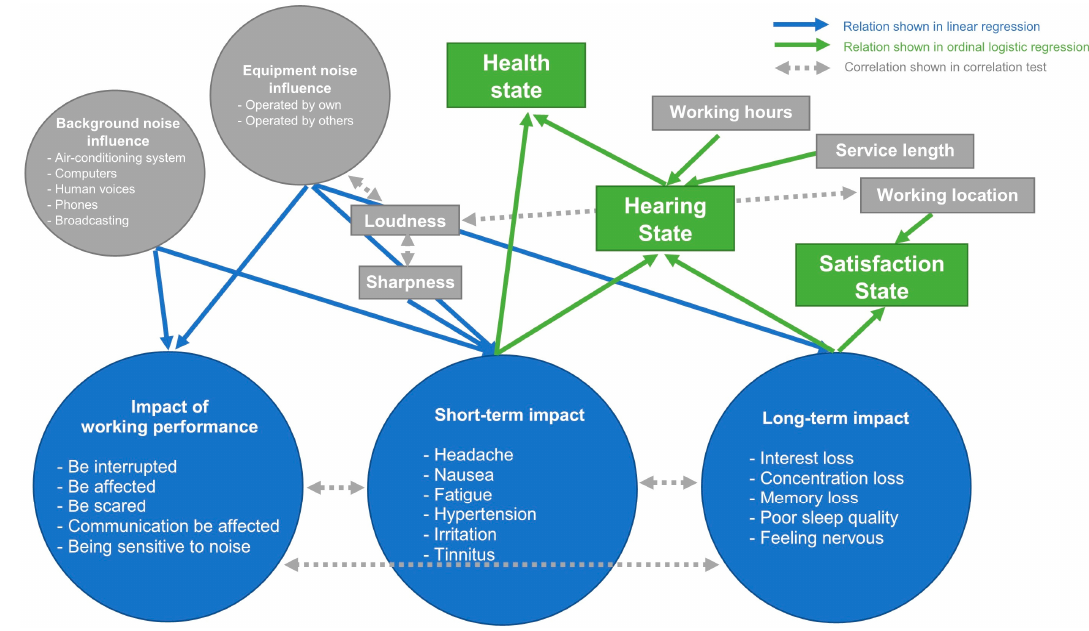
Figure 5. The health risk model connected the environmental changes to the dental professionals’ health condition.